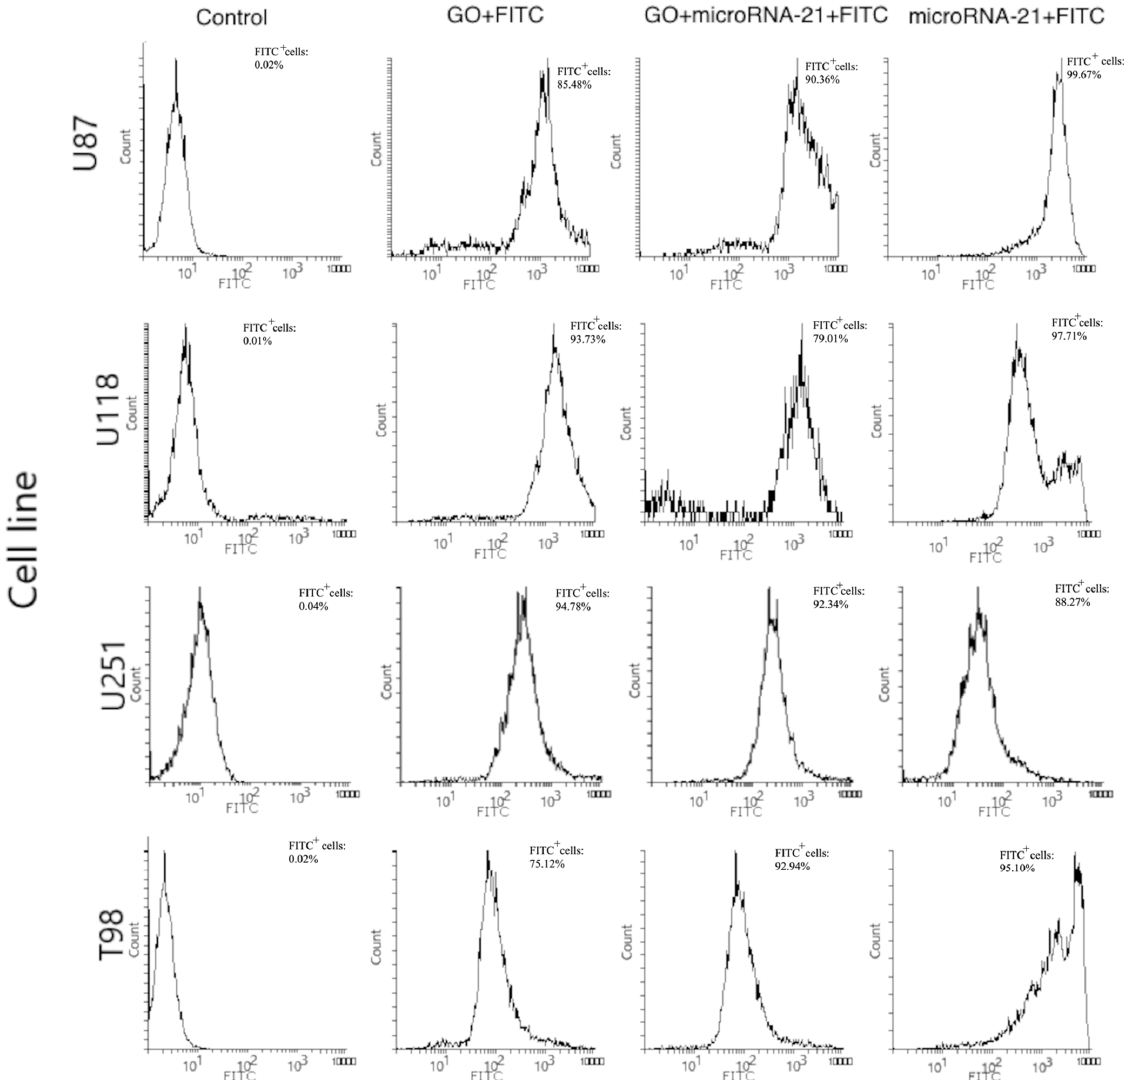
Figure 17. Flow cytometric analysis of unstained and FITC-stained cells of U87, U118, U251, T98. Forward scatter (FSC) vs. side scatter (SSC) two-dimensional (2D) dot plots of unstained cell population (Control), FITC-labelled GO cell population (GO + FITC), FITC-labelled GO + antisense miRNA-21-stained cell population (GO + miRNA-21 + FITC), FITC labelled antisense miRNA-21-stained cell population (miRNA-21 + FITC). Abbreviations: FITC + –FITC positive cells.